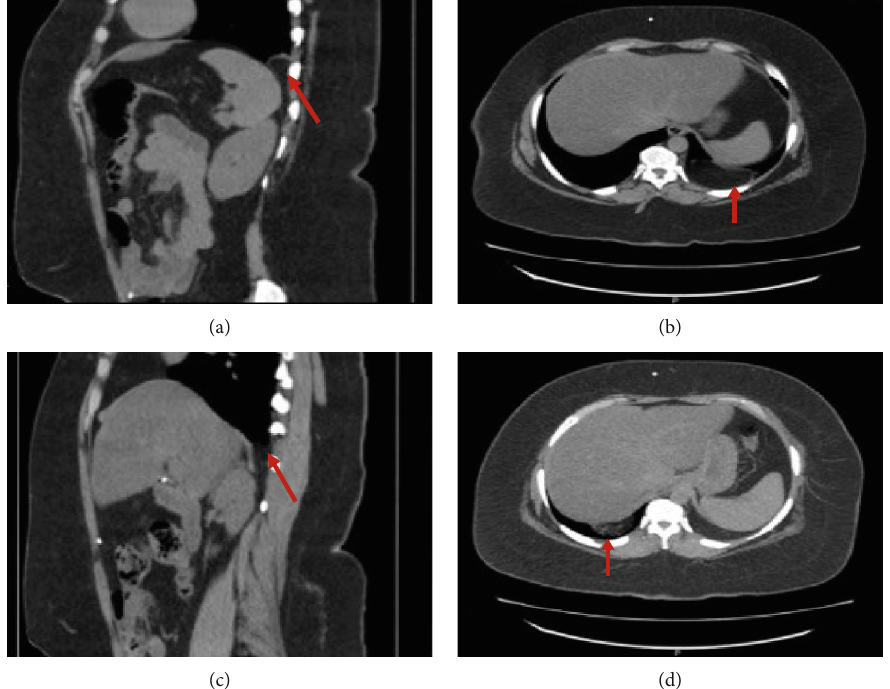
Figure 3: Computed Tomography (CT) scan of the abdomen showing a 1.6cm left-sided Bochdalek Hernia in a sagittal (a) and axial (b) plane containing fat (red arrow) and a 1.5cm right-sided Bochdalek Hernia in a sagittal (c) and axial (d) plane containing only fat (red